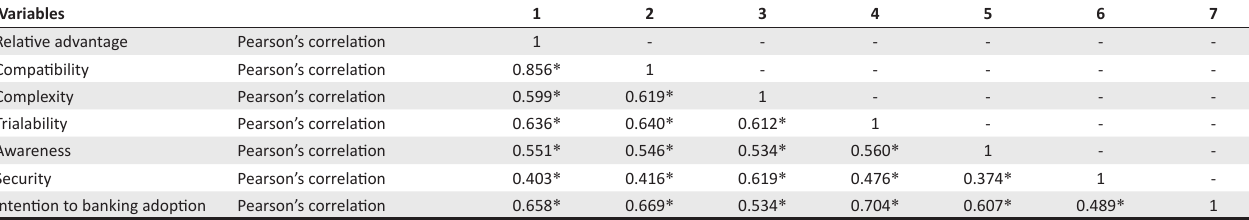
TABLE 2: Correlation analysis results in the